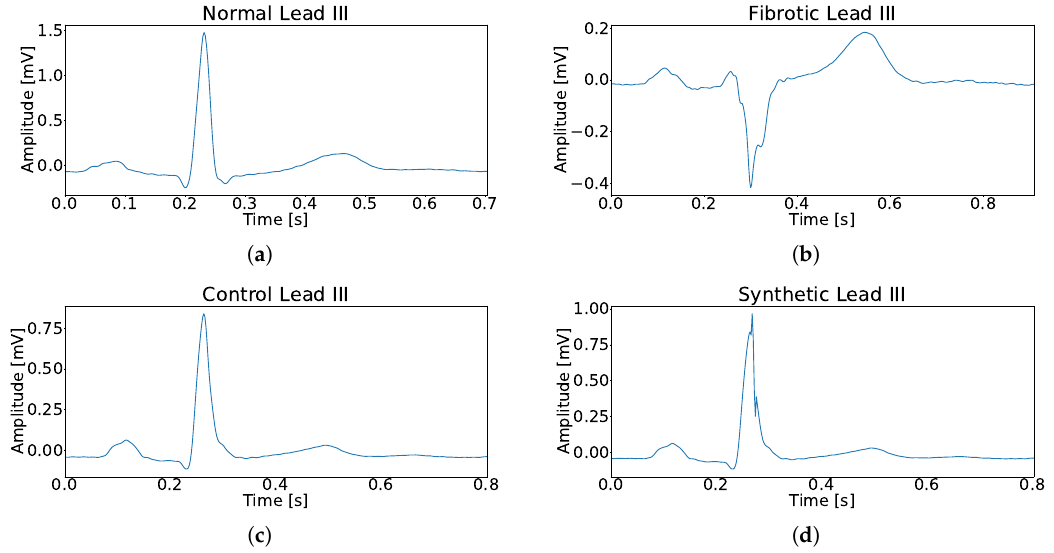
Figure 1. Example for each type of used register in this work. ( a ) Example of a beat without fragmentation. ( b ) Example of a fragmented beat. ( c ) Example of a beat from control patient. ( d ) Example of a synthetically fragmented